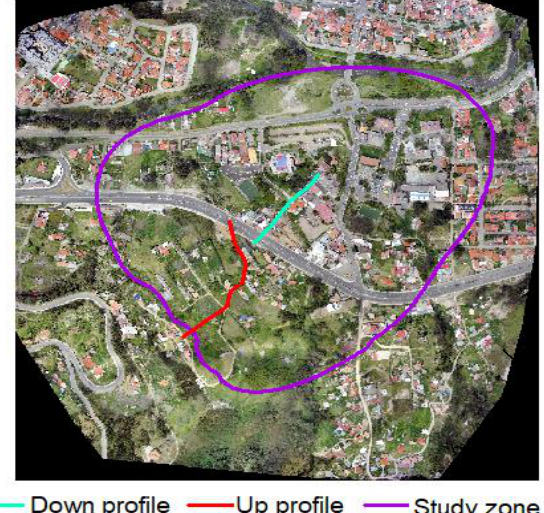
Figure 6 Study zone. Location of profiles UP, DOWN. Figure 5. Approved points and camera uncertainty of the point cloud ( Jun 20, 18 ) 3.1 Geo-referencing LiDAR (Dec 06, 17)-UAV (Feb 02, 18) Table 6. Geolocation errors, point cloud from Jun 20,18 To perform the referencing, five points located in the upper corners of different premises were taken. Four of them located in the upper part of the escarpment, an area in which there are no movements, and the other point located in the corner of a building, where mass movement produces displacements in the field. Figure 7 illustrate the location map of the selected points.